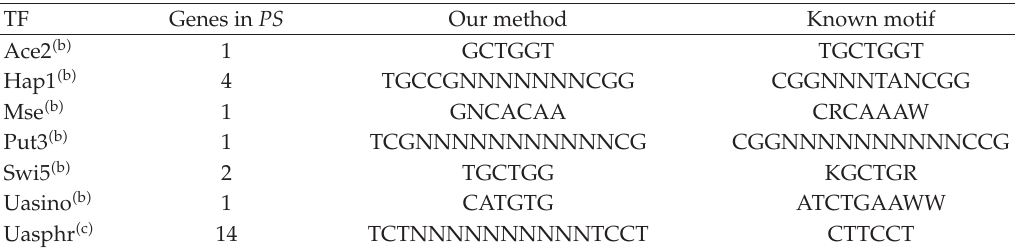
Table 7: The TFs whose known binding motifs cannot be found by MEME / AlignACE / PHYME , but can be found using our method. Three di ff erent parameter threshold settings, namely, (cid:2) a (cid:3) , (cid:2) b (cid:3) , and (cid:2) c (cid:3) , are used in our method as given in Table 2. Our